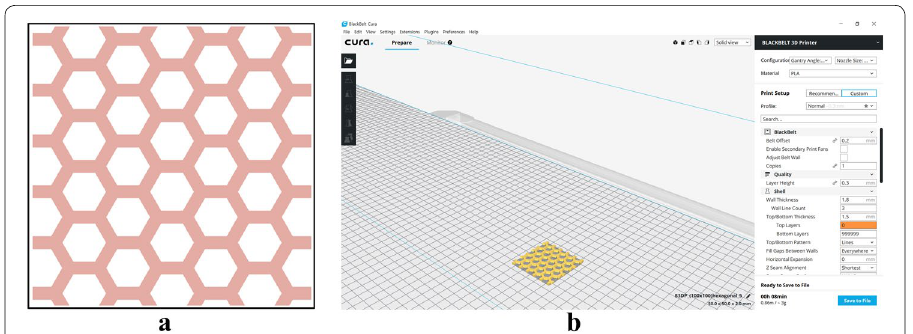
Fig. 1 Scheme of a honeycomb structure; b 3D modelling